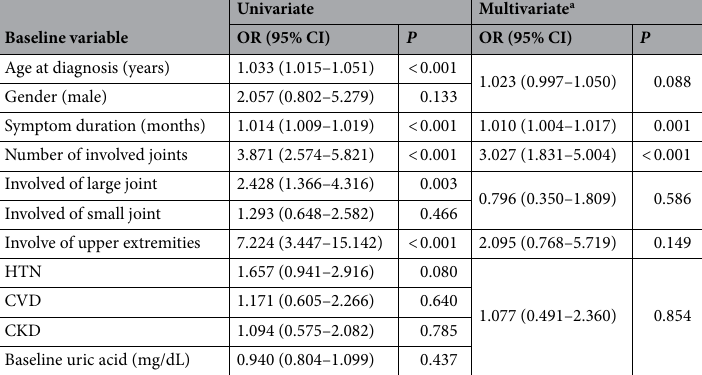
Baseline variable